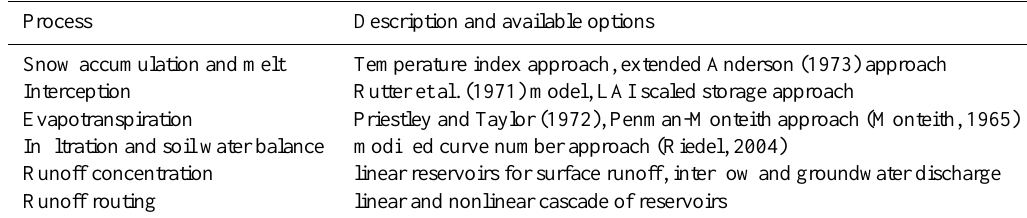
Table 1. Representation of processes in Panta Rhei (adapted from Riedel, unpublished data).